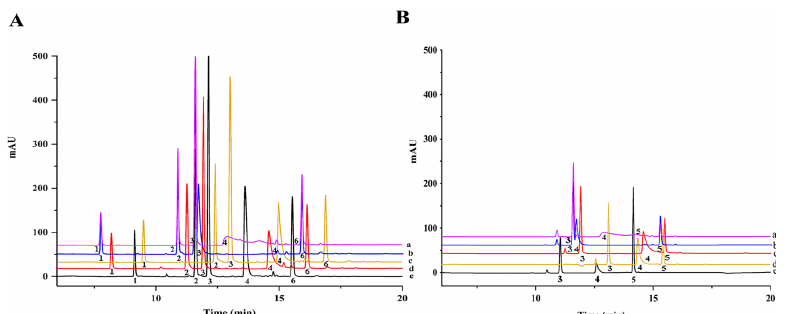
Figure 1. Effects of different compositions of mobile phase on the HPLC chromatogram of coccidiostats at 270 nm ( A ) and 340 nm ( B ): 1, clopidol; 2, dinitolmide; 3, sulfaquinoxaline; 4, robenidine; 5, nicarbazin; 6, diclazuril. The composition of mobile phase: a (pink colour), acetonitrile-water; b (blue colour), methanol-water; c (red colour), methanol-5 mmol/L ammonium acetate aqueous solution; d (yellow colour) , methanol-10 mmol/L ammonium acetate aqueous solution; e (black colour), methanol-5 mmol /L ammonium acetate aqueous solution (containing 0.1% formic acid).